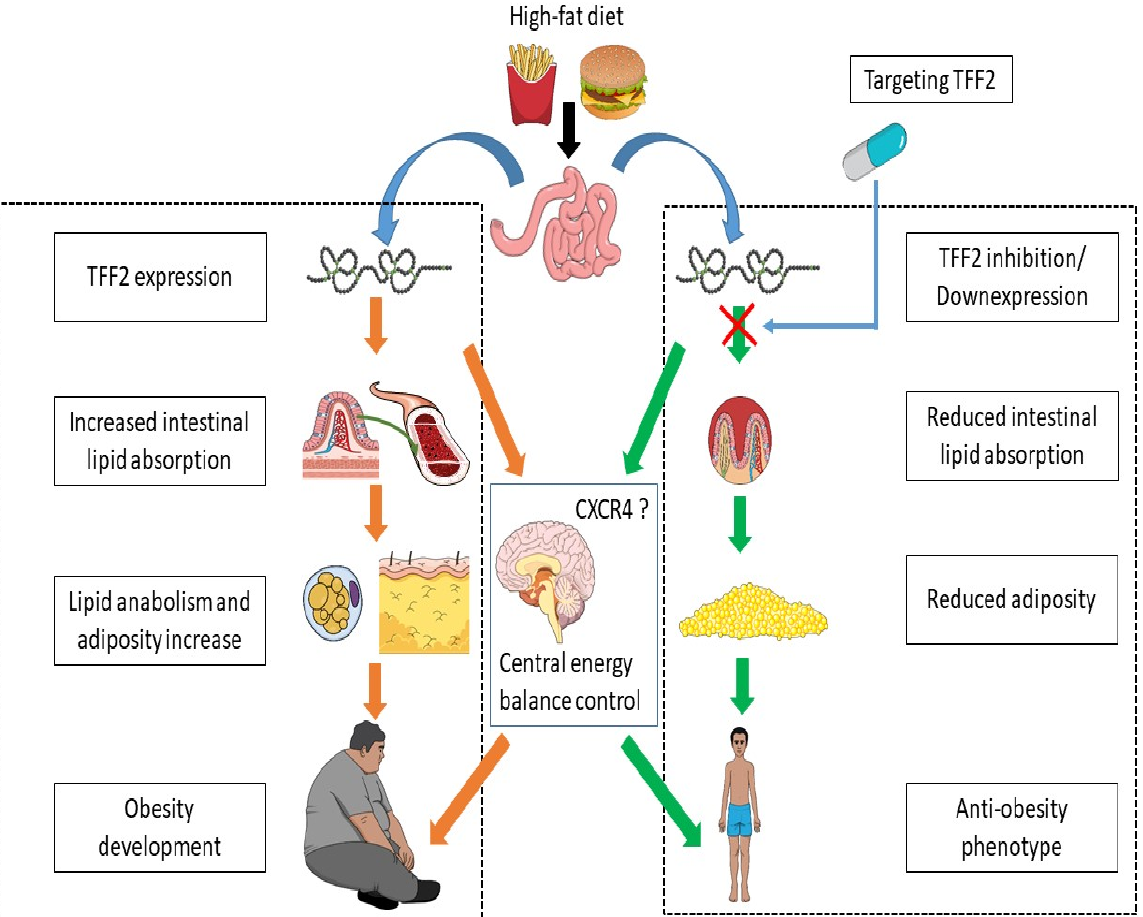
Figure 2. TFF2 hypothetic implications in obesity development and its potential therapeutic targeting. The high-fat diet increases TFF2 expression. This would lead to the facilitation of the intestinal lipid absorption, as well as the increase in lipids storage in part, at least, via increasing anabolism. All these contribute to obesity development. Thus, inhibiting or reducing the expression or the action of TFF2 would reduce the lipid intestinal absorption as well as the adiposity. That points targeting TFF2 and its related pathways as a potential antiobesity therapeutic approach. Both TFF2 action and inhibiting TFF2 mechanisms would involve CXCR4 pathways. Abbreviations: CXCR4, chemokine (C-X-C motif) receptor 4; TFF2, trefoil factor family member